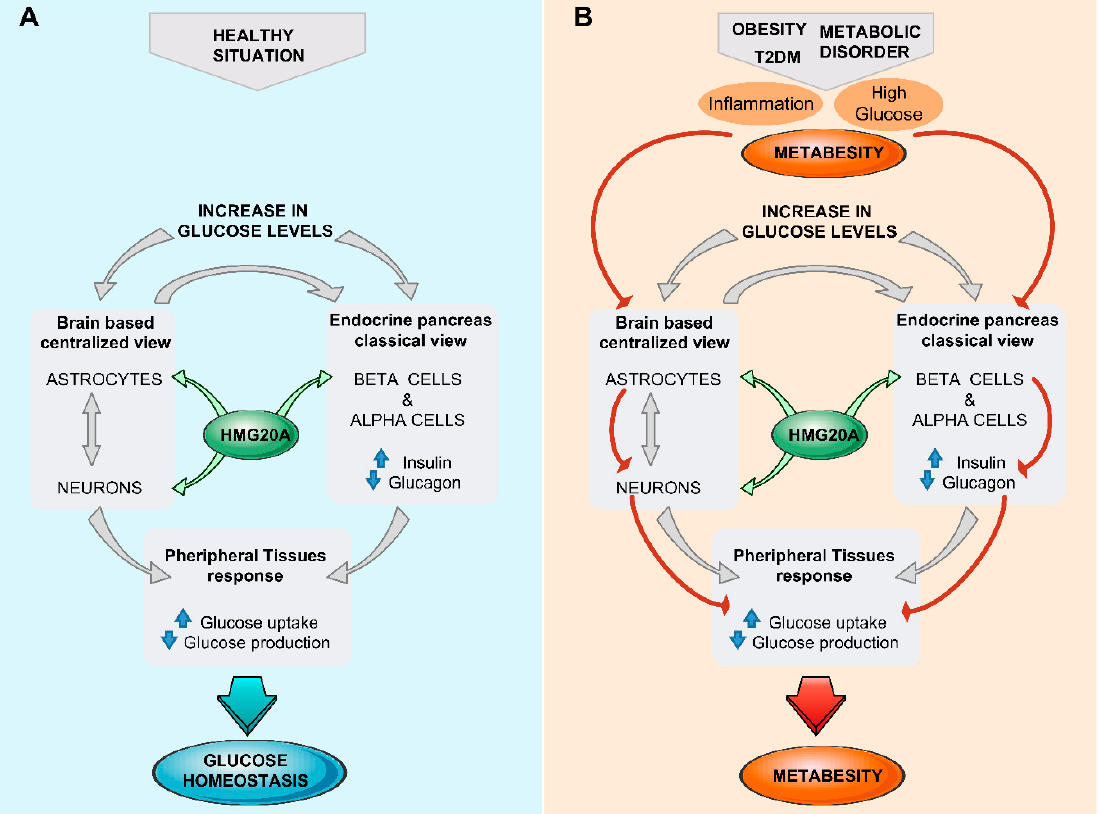
Figure 2. The brain (astrocyte)/islet axis in metabesity. ( A ) In response to increased glucose levels, a dialogue between brain astrocytes/neurons and islets coordinates glucose homeostasis by peripheral tissue relaying. The chromatin-remodeling factor HMG20A is a common denominator expressed in both astrocytes and islets that facilitates integration of input signals. ( B ) In the advent of metabesity, characterized by obesity, insulin resistance, and inflammation, which alter the expression of HMG20A, the brain/islet axis is short-circuited, precipitating the disease state. T2DM, type 2 diabetes mellitius.